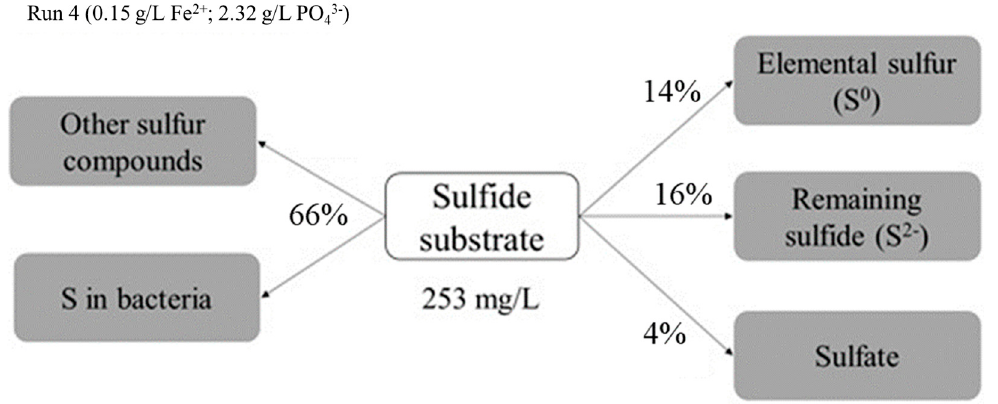
Figure 4. Schematic of the sulfur balance.